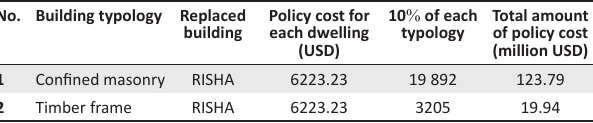
TABLE 4: Breakdown of total amount to be subsided for confined masonry and timber frame